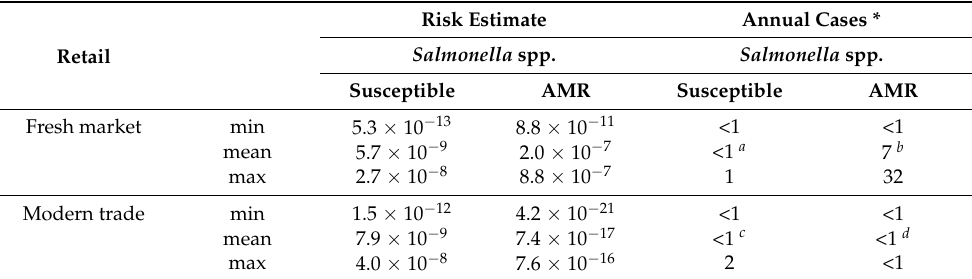
Table 4. Descriptive statistics of risk estimate ( P FM ) and annual mortality rate ( M AFM ) from consum- ing pork contaminated with susceptible and AMR Salmonella